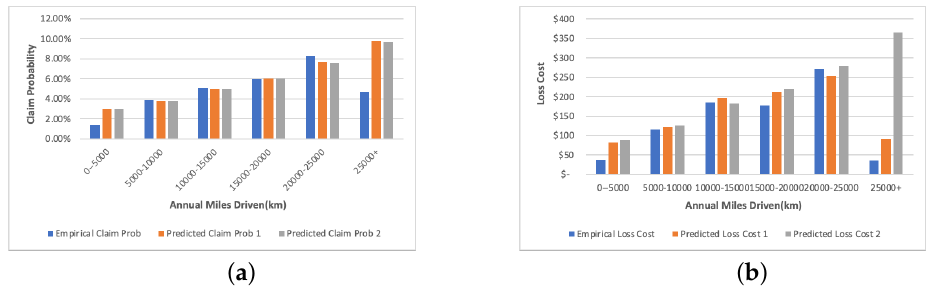
Figure 5. Comparison of empirical and the predicted values of claim probability and loss cost by Annual Mileage Driven ( a ) presents the results of claim probability. ( b ) corresponds to the loss cost. The orange bar shows results for predictions without using clusters. The grey bar presents results for predictions with designed clusters.